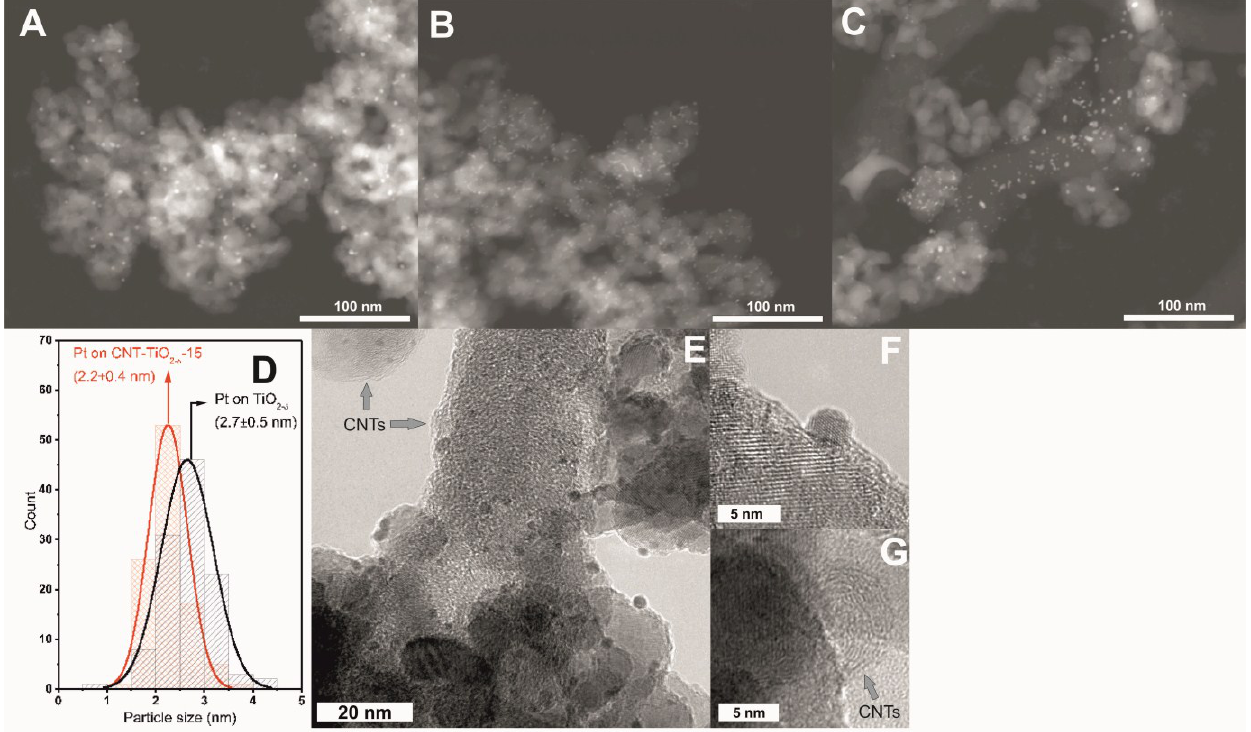
Figure 6. Representative STEM images for TiO 2−δ ( A ), CNT-TiO 2−δ -15 ( B ) and CNT-TiO 2−δ -60 ( C ) with photodeposited Pt nanoparticles and after photocatalytic reactions; particle size distributions of the Pt nanoparticles on CNT-TiO 2−δ -15 and on TiO 2−δ ( D ); TEM image of the CNT-TiO 2−δ -15 with photodeposited Pt nanoparticles ( E) ; HRTEM image of Pt nanoparticle on CNT-TiO 2−δ -15 ( F ); HRTEM image